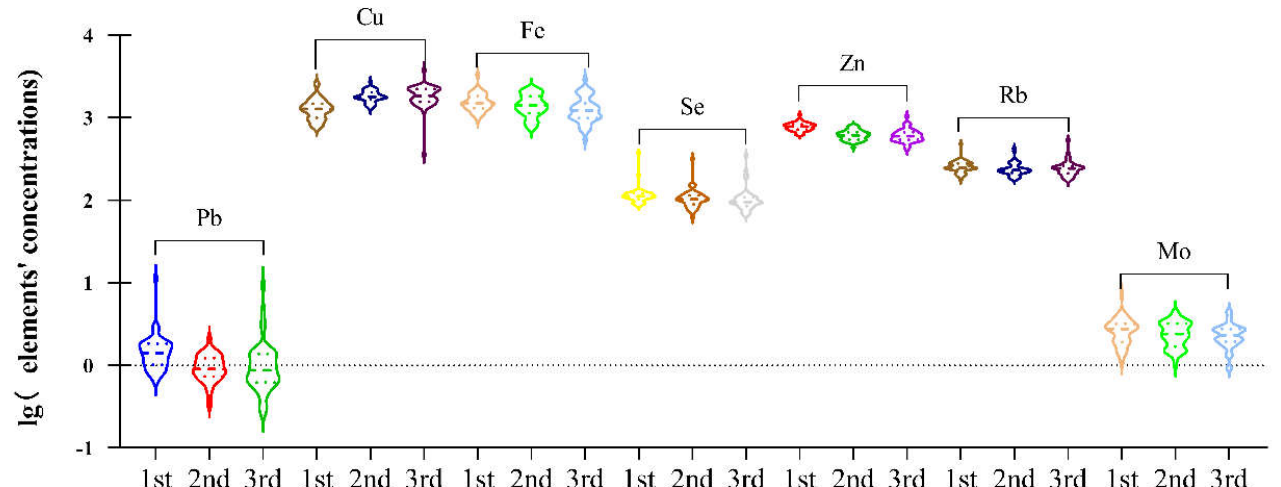
Figure 1. Violin plot of toxic and essential elements, in maternal plasma at 1st, 2nd and 3rd trimester. The plot was established based on the significant difference calculated by the Friedman test ( p < 0.05) among plasma elements Pb, Cu, Fe, Se, Zn, Rb and Mo. Table 3. Differences in element concentrations in maternal plasma at 3rd trimester and cord